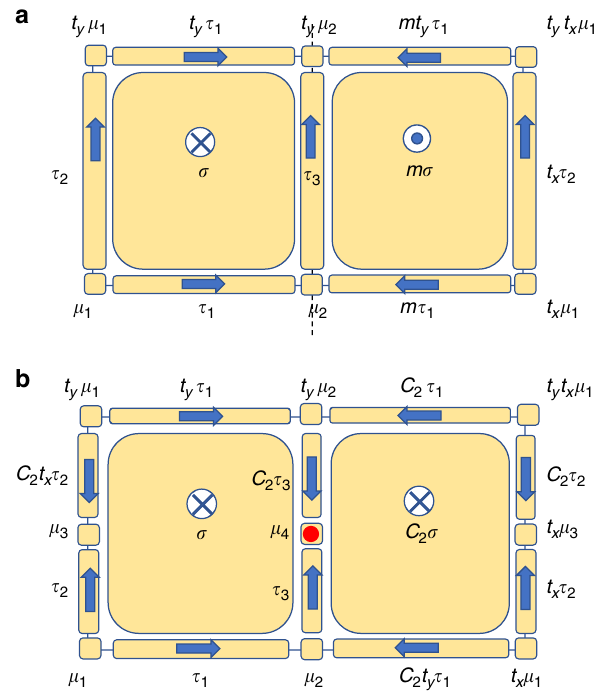
Fig. 1 Cell decomposition for 2D wallpaper groups. a The cell decomposition for 2D wallpaper group Pm . The mirror line is the vertical dashed line. b The cell decomposition for 2D wallpaper group P 2. The rotation center is marked in red. In both panels, the independent cells are labeled by σ 1,2,3, … ( τ for 1-cell and μ for 0-cell), and the other cells are labeled as g σ with g ∈ G . Their orientations are marked by